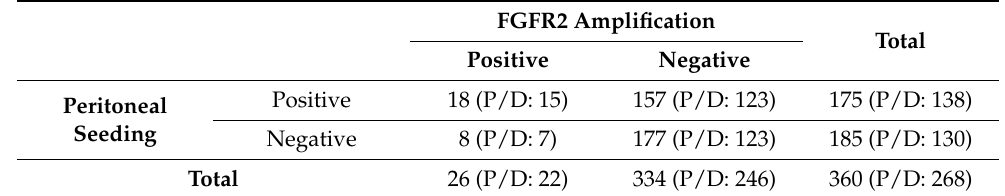
Table 1. Summary of 360 cases with key features. Associations between peritoneal seeding and FGFR2 amplification; peritoneal seeding and poorly differentiated (P/D) carcinoma were statistically significant. Associations between FGFR2 amplification and P/D carcinoma were not significant.